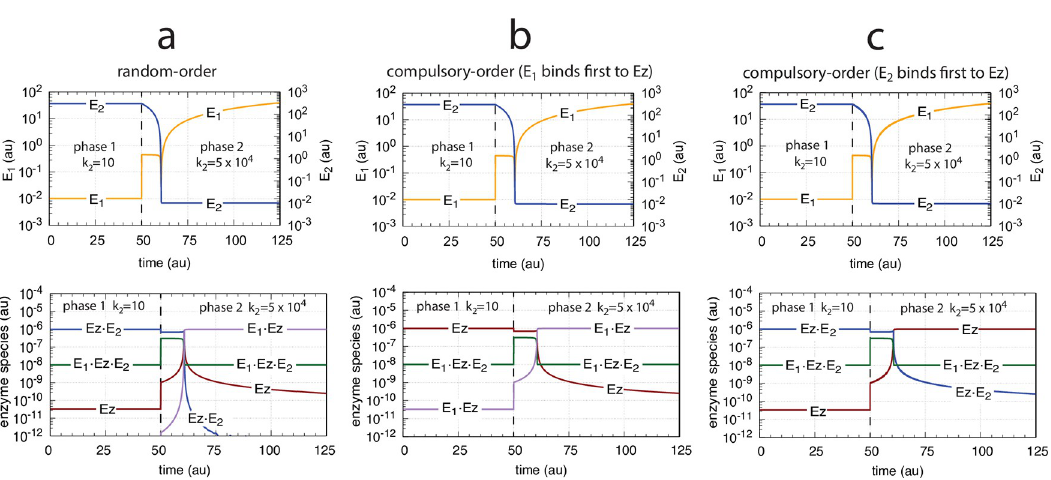
Fig 26. Concentration profiles of E 1 , E 2 , and enzyme species with respect to the controllers’ breakdown shown in Fig 25d. Column a: Random-order mechanism (Fig 19). Column b: Compulsory-order mechanism (Fig 24a). Column c: Compulsory-order mechanism (Fig 24b). Rate constants and initial concentrations as in Fig 25.